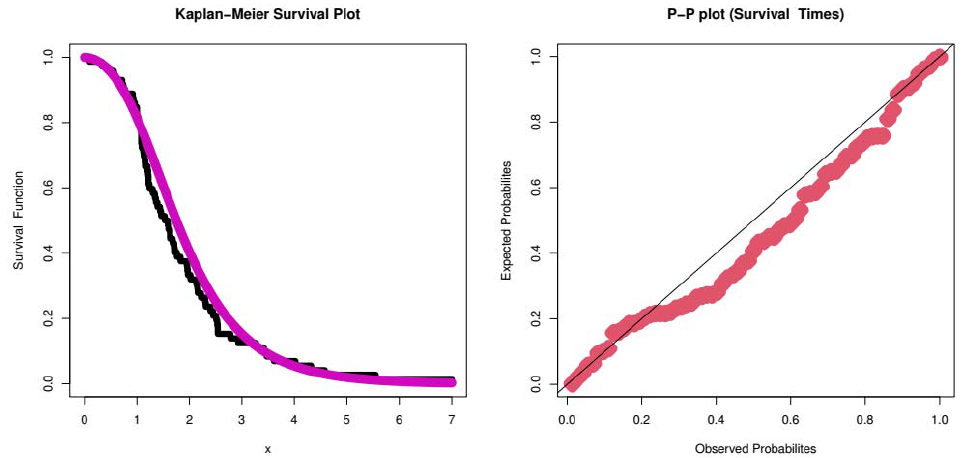
Figure 7. Kaplan–Meier survival plot ( left panel ) and P–P plot ( right panel ) for survival times data.